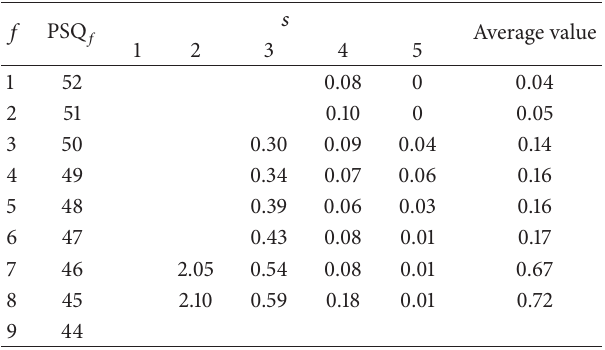
Table 4: The results of differential analysis between TL 𝑓𝑠 and TL 𝑓(𝑠+1) .